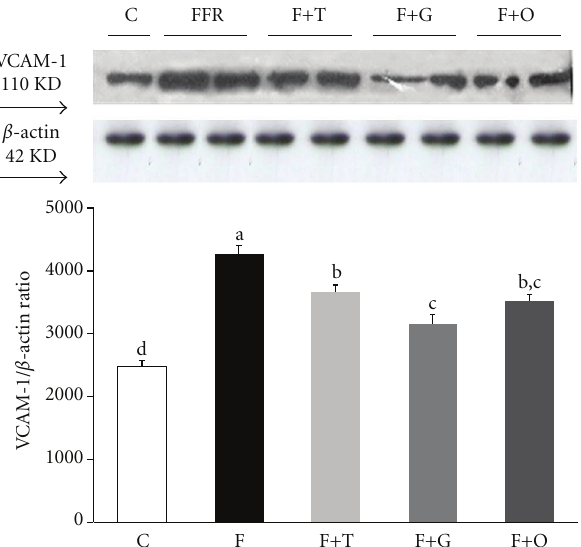
Figure 4: Vascular cell adhesion molecule-1 (VCAM-1) protein expression in vascular mesenteric tissue assessed by western blotting from C, F, F+T, F+G, and F+O groups. Values are expressed as mean ± SEM, ( n = 4); bars with di ff erent superscripts di ff er, P < 0.05. reduction of VCAM-1 expression. The western blot